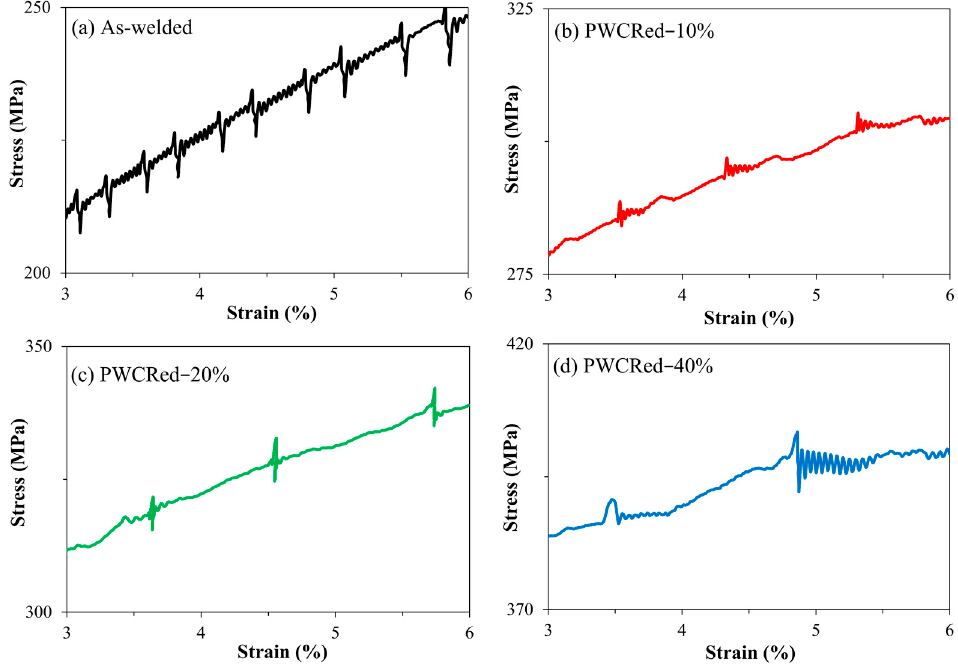
Figure 6. Portevin-Le Chatelier (PLC) behaviour of the as-welded and PWCRed